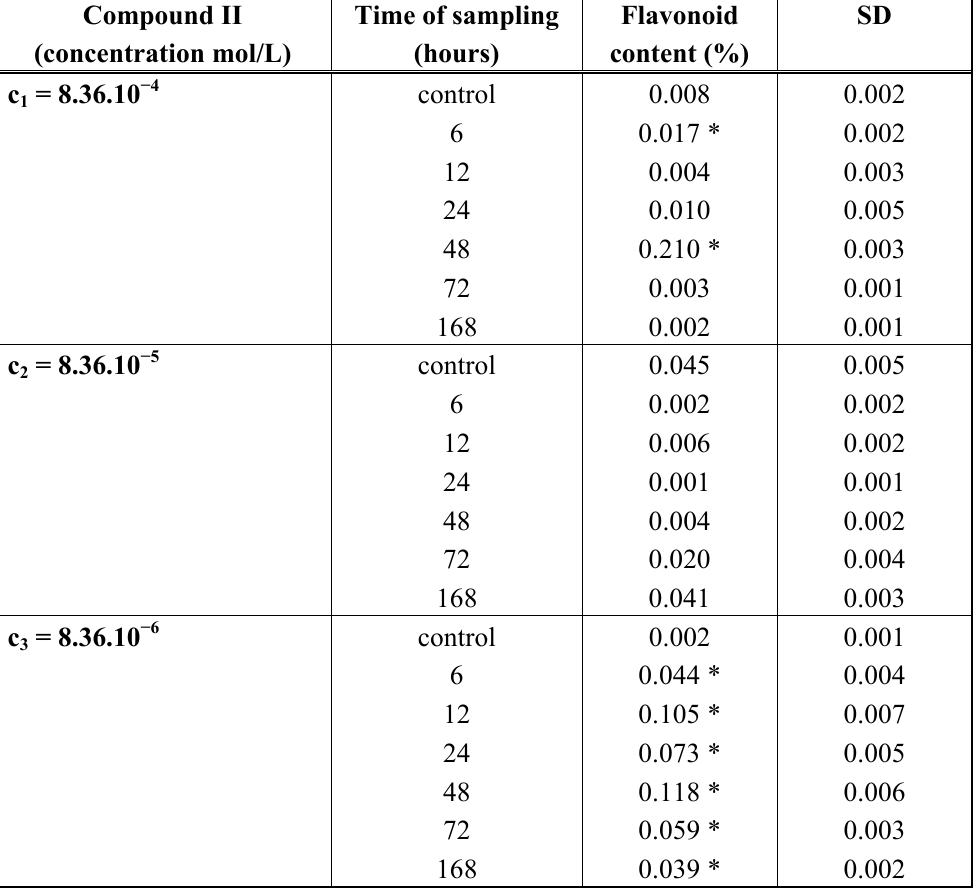
Table 5. Flavonoid content (%) in suspension culture of Ononis arvensis